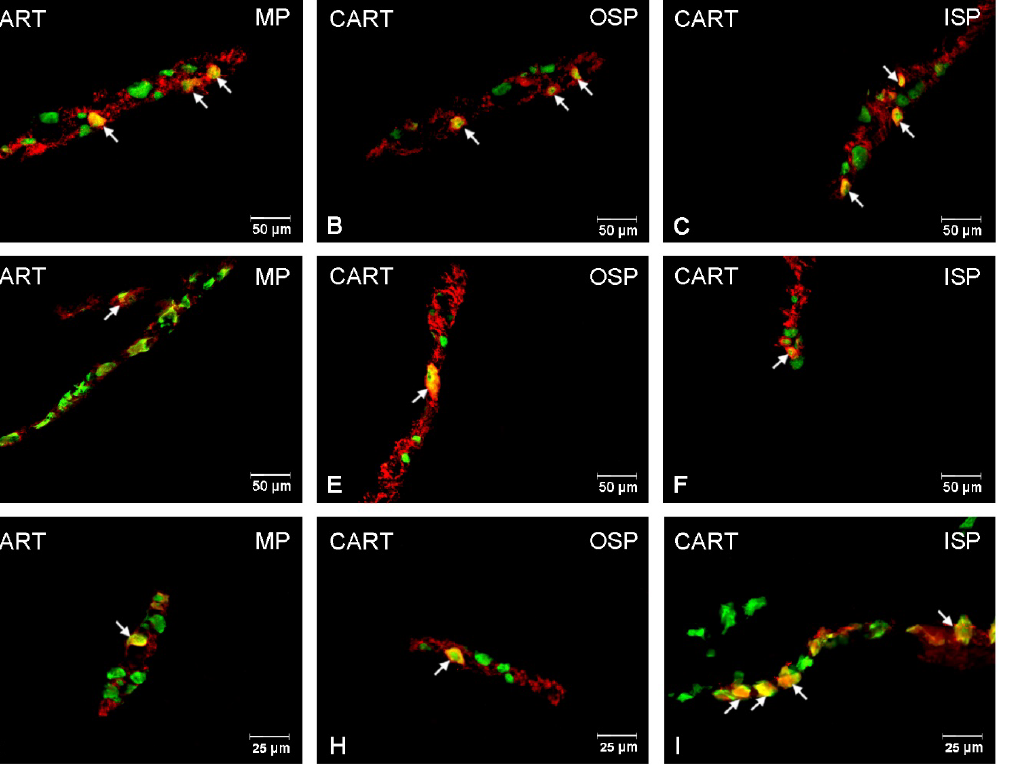
Figure 2. Fluorescence microscopy images showing protein gene product 9.5 (PGP 9.5) visible as green fluorescence that colocalizes with cocaine and amphetamine regulated transcript (CART) visible as red fluorescence in the enteric neurons of the jejunum in pigs. The obtained images were